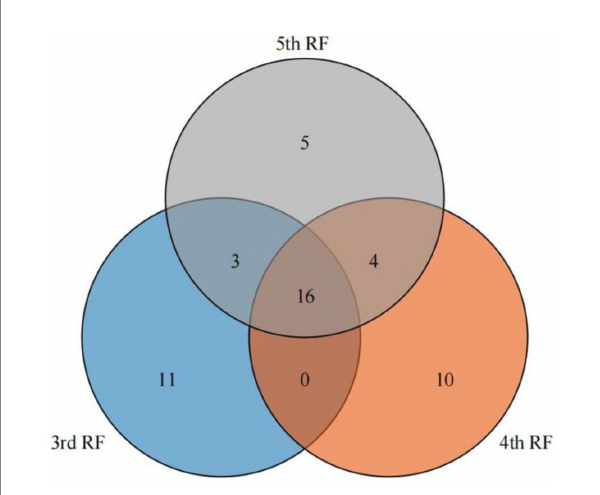
FIGURE 5 Venn diagram of differential compounds of different quality grades of base liquor of 3rd, 4th and 5th round of